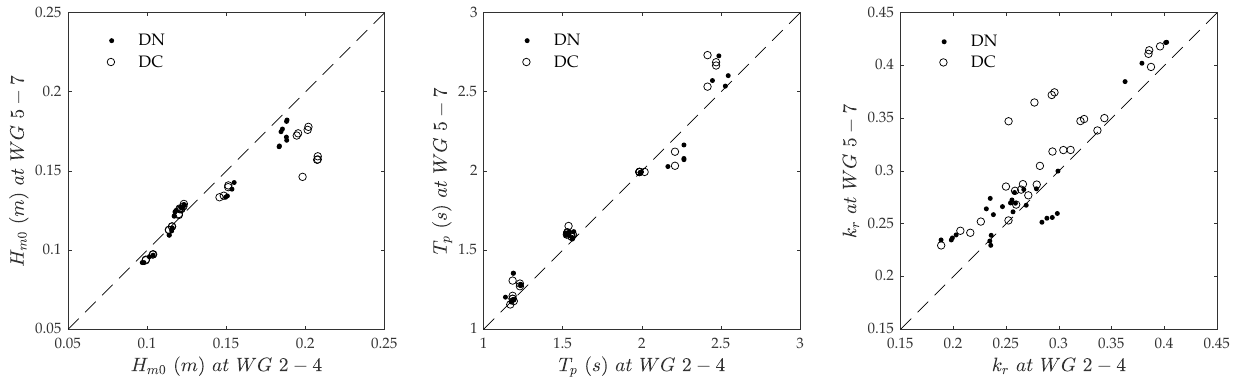
Figure 8. Comparison of wave characteristics of WG 2–4 and W G5–7 for DN and DC